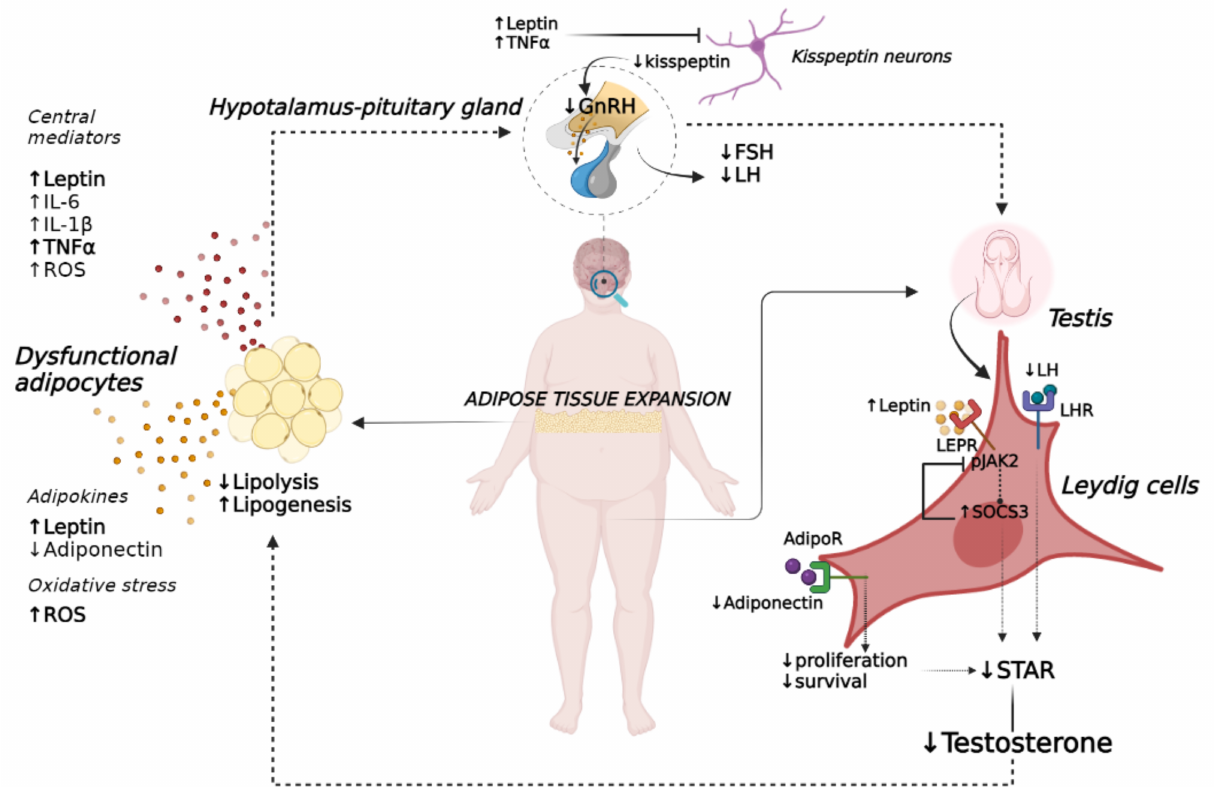
Figure 1. The vicious cycle of obesity–hypogonadism. Obesity-induced AT dysfunction impaired the secretion of several mediators affecting the release of GnRH from the hypothalamus as well as of FSH and LH from the pituitary gland. Low levels of these hormones worsen testicular function in terms of the reduction of testosterone production, leading to overt hypogonadism. The decrease in testosterone levels further exacerbates the impairment of AT in terms of a decreased rate of lipolysis and increased lipogenesis, the extent of which accelerates the failure of HPT axis, thus sustaining a feedforward detrimental loop. Abbreviations: adiponectin receptor (AdipoR); follicle-stimulating hormone (FSH); gonadotropin-releasing hormone (GnRH); interleukin-1 β (IL-1 β ); interleukin-6 (IL-6); suppressor of cytokine signaling 3 (SOCS3); tumor necrosis factor α (TNF α ); leptin receptor (LEPR); luteinizing hormone (LH); LH receptor (LHR); phosphorylated Janus kinase 2 (pJAK2); reactive oxygen species (ROS); steroidogenic acute regulatory protein (STAR); signal transducer and activator of transcriptor 3